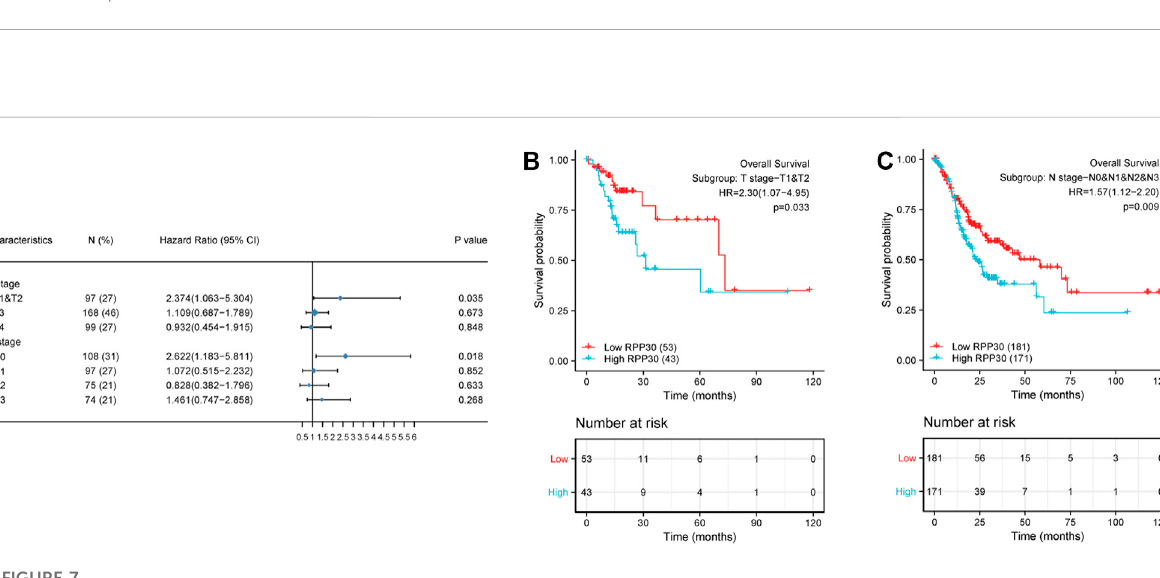
FIGURE 6 Validation of RPP30-based nomogram for GC patients. (A) Effect of RPP30 expression on the OS of GC patients in TCGA cohort. The results showedthathigher RPP30expressionwasassociated withpoorOS(HR=1.53[1.10 – 2.14], p =0.012). (B) Nomogramforthepredictionof1-,3-, and 5-years OS of GC patients. The C-index was 0.704 (95% CI = 0.680 – 0.728). (C) The calibration plot of the nomogram indicated a good agreement between the prediction and the ideal line.